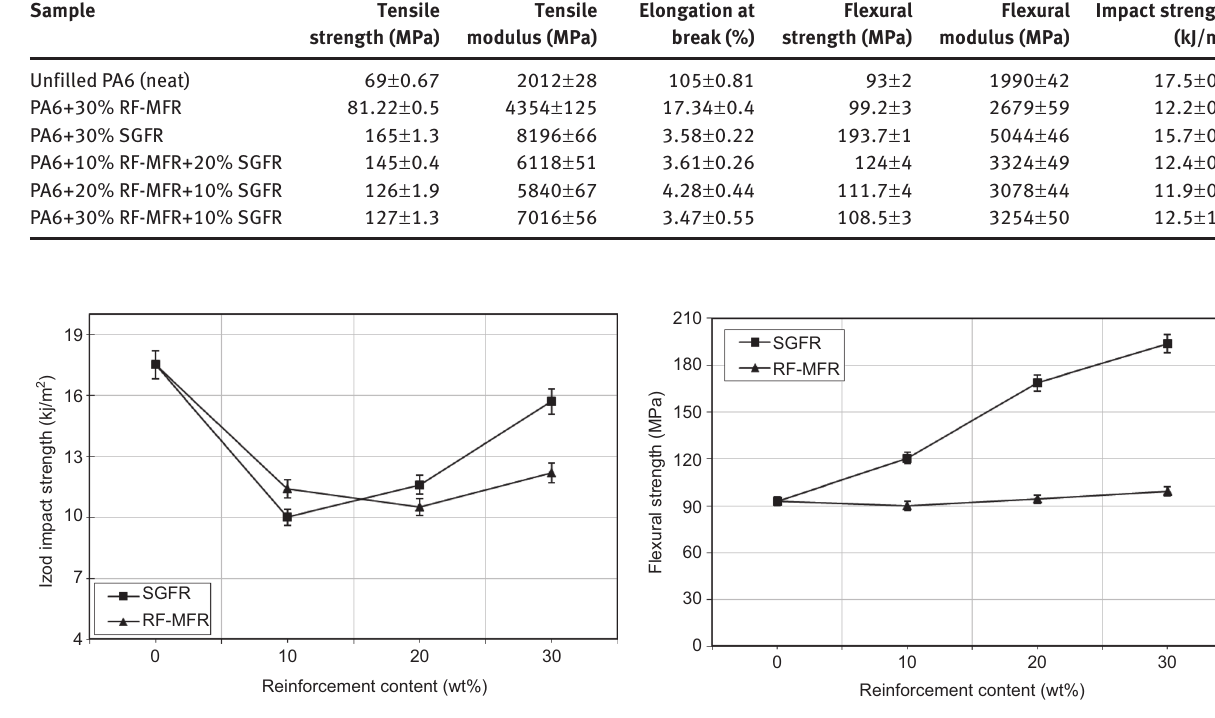
Figure 4 Variation of the impact strength of PA6 with weight percent of reinforcement content.